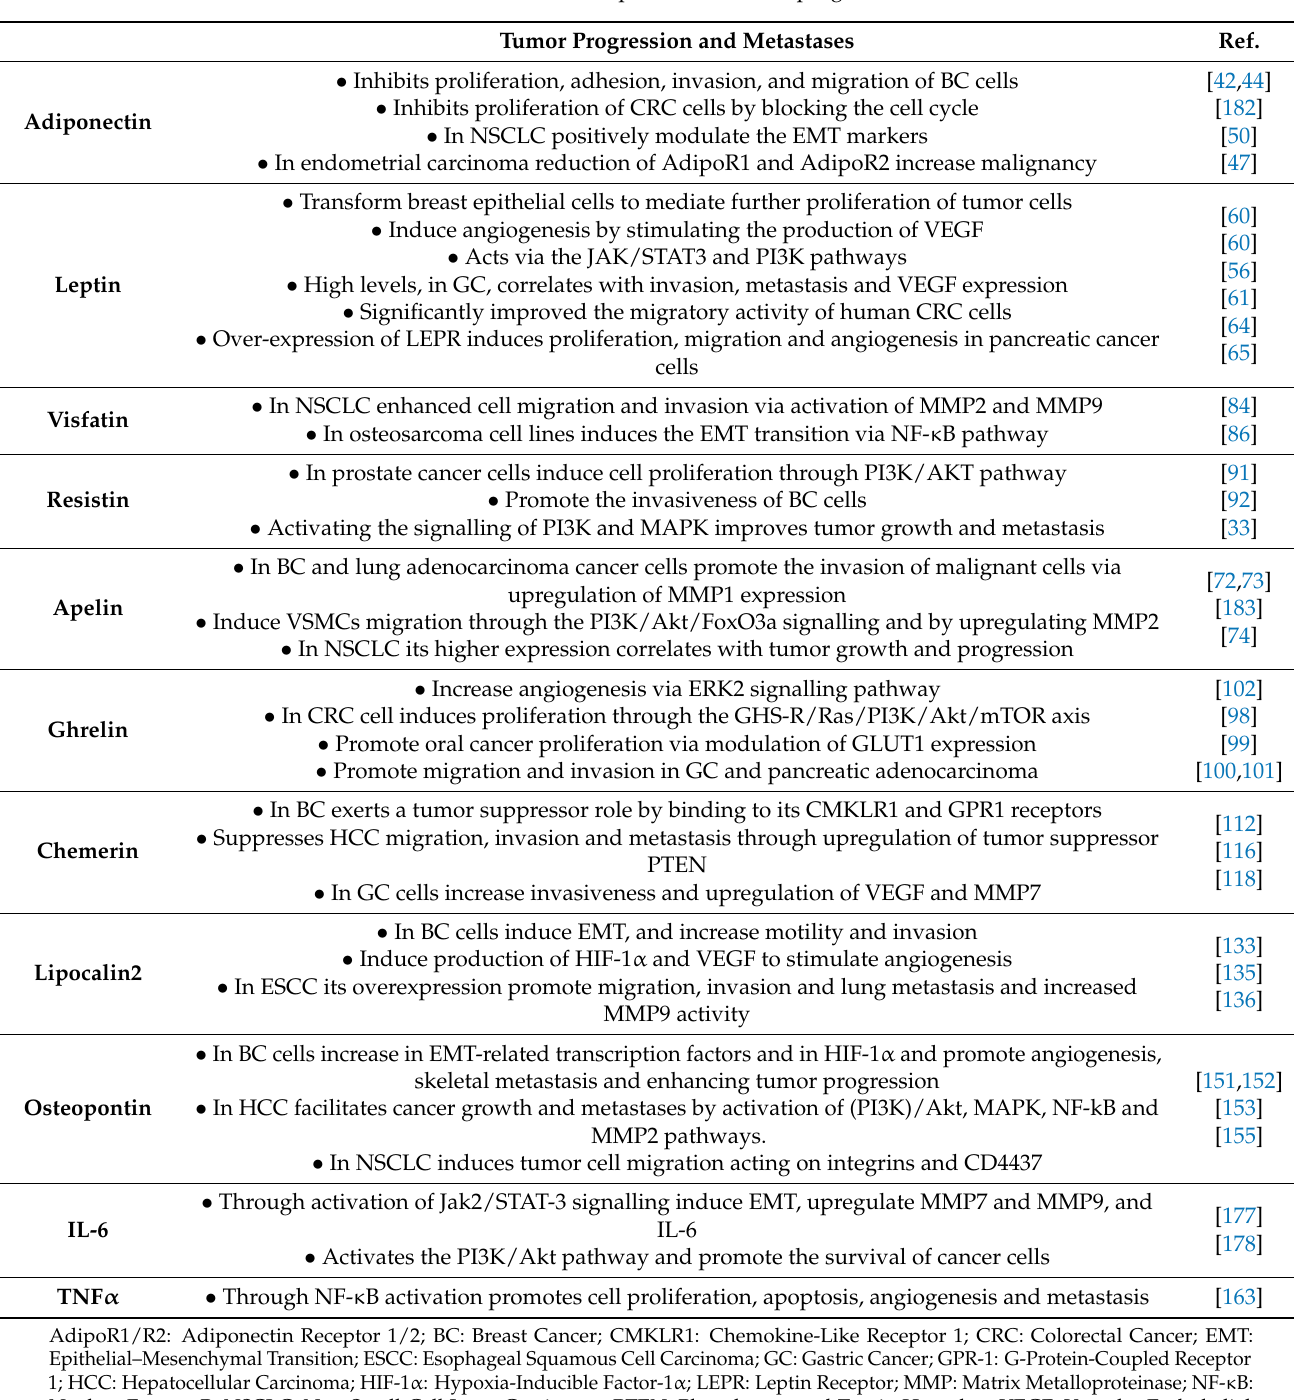
Table 1. The roles of adipokines in cancer progression. Tumor Progression and